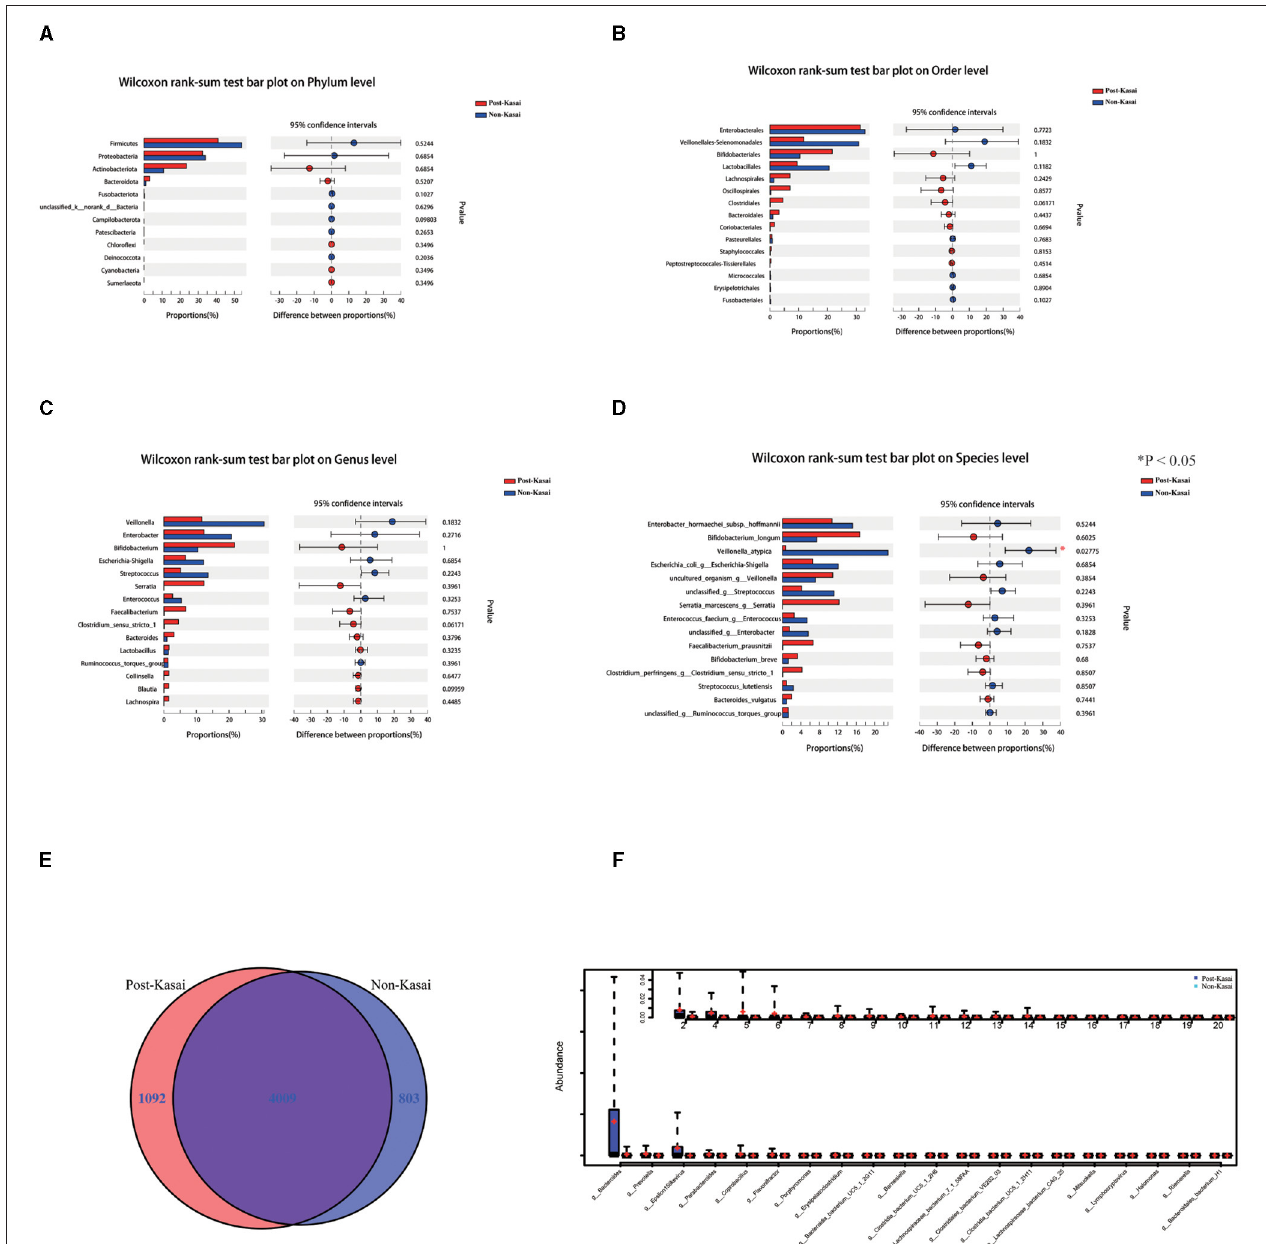
FIGURE 1 | (A–D) Differential gut microbiota between the post-Kasai and non-Kasai groups at the phylum, order, genus and species levels (* P < 0.05, 16S rRNA genes). (E) Venn diagram of the post-Kasai and non-Kasai groups at the species level. (F) Differential gut microbiota between the post-Kasai and non-Kasai groups performed by metagenomic